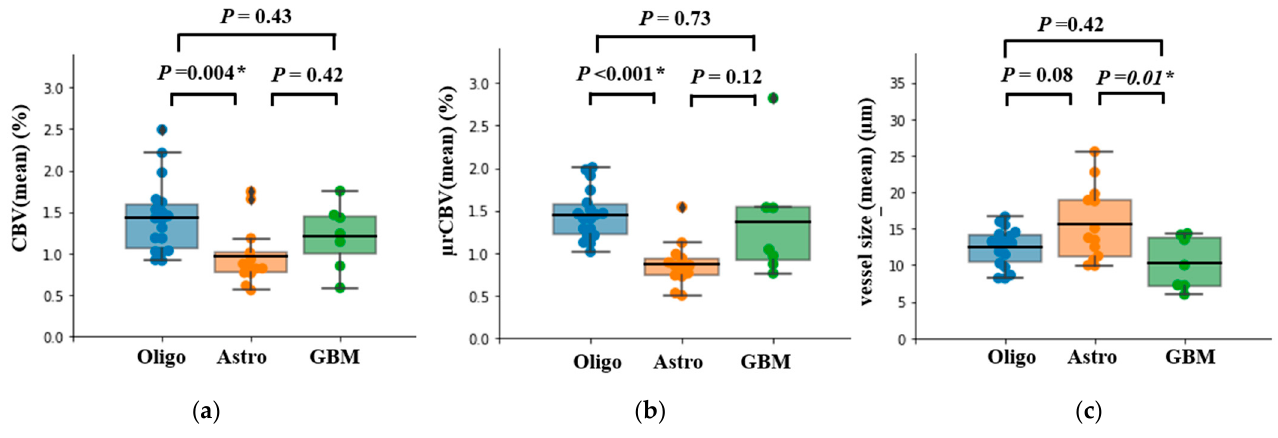
Figure 2. Box plot of MRI-derived measurements of ( a ) CBV, ( b ) µCBV, and ( c ) vessel size, with mean bar for the three glioma subtypes Oligo (IDH-mut &1p/19q codeleted), Astro (IDH-mut), and GBM (IDH-wt). Tukey HSD test or Dunn’s test using a Bonferroni correction was used for pairwise statistical analysis. ‘*’ indicates significant difference between two subtypes accompanied by the exact p -value.